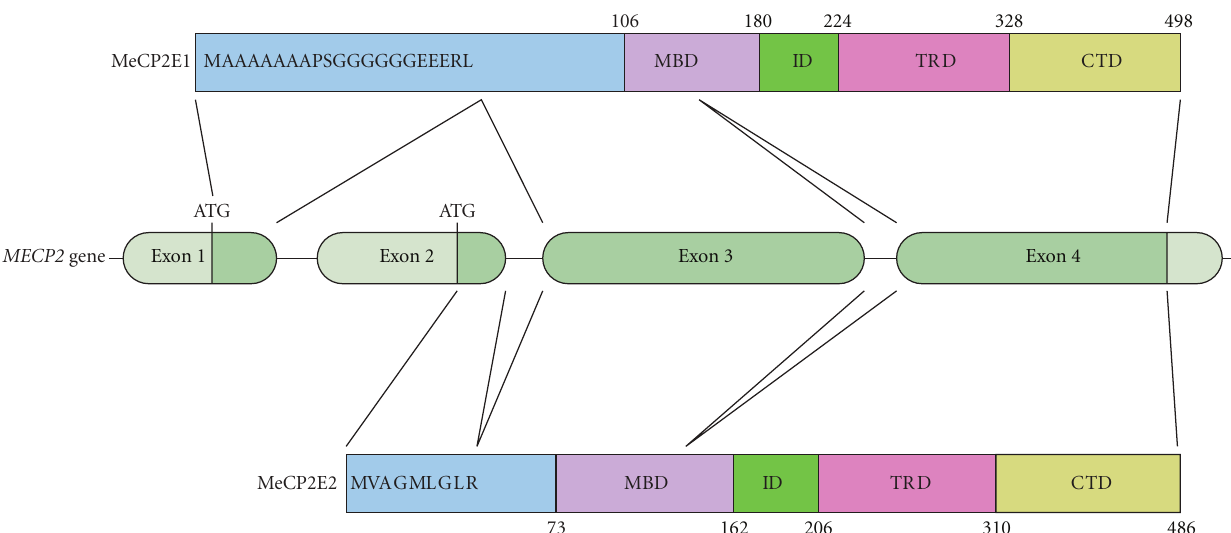
Figure 2: MECP2 gene and protein isoforms. Schematic illustration of the gene structure of MECP2 and the di ff erent domains of the two protein isoforms,MeCP2E1 and MeCP2E2. The primary amino acid composition of the N-terminus of MeCP2E1 and MeCP2E2 is